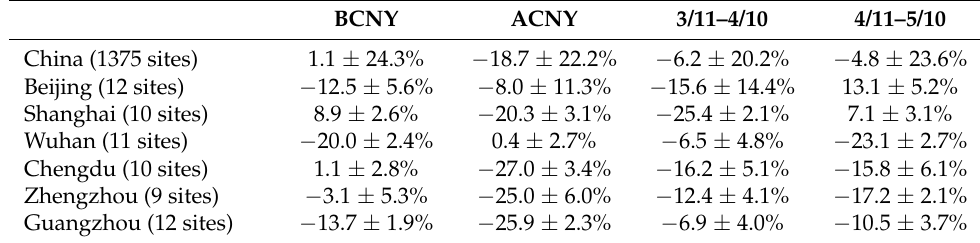
Table 1. The mean and standard deviation (std) of the relative change in CO surface concentrations. BCNY